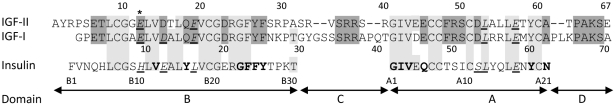
The amino acid sequence alignment of IGF-II, IGF-I, and insulin.Insulin residues important for IR binding and defined as site 1 residues (ValB12, TyrB16, GlyB23, PheB24, Phe B25, TyrB26, GlyA1, IleA2, ValA3, GlnA5, TyrA19, AsnA21) are shown in bold type and those defined as site 2 residues (HisB10, GluB13, LeuB17, SerA12, LA13, Glu17) are underlined and in italics [18]. IGF-I and IGF-II site 2 residues are underlined and in italics. Conserved residues are boxed in light gray, residues conserved between IGF-II and IGF-I are boxed in dark gray and the domain structure is below. Residue Glu 12 of IGF-II mutated in this study is highlighted with an asterisk.